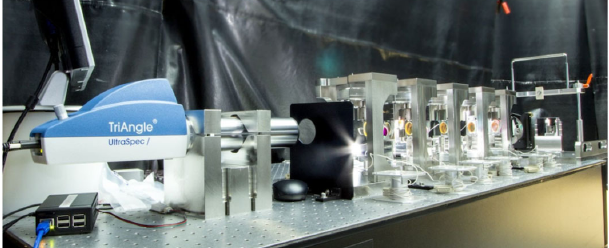
FIG. 19. View of the cascade test bench for the MPS before the installation of the top cover. On the left the autocollimator, in the center the MPS mounted alternatively on the optical and on the upside down support and on the right the reference flat mirror.